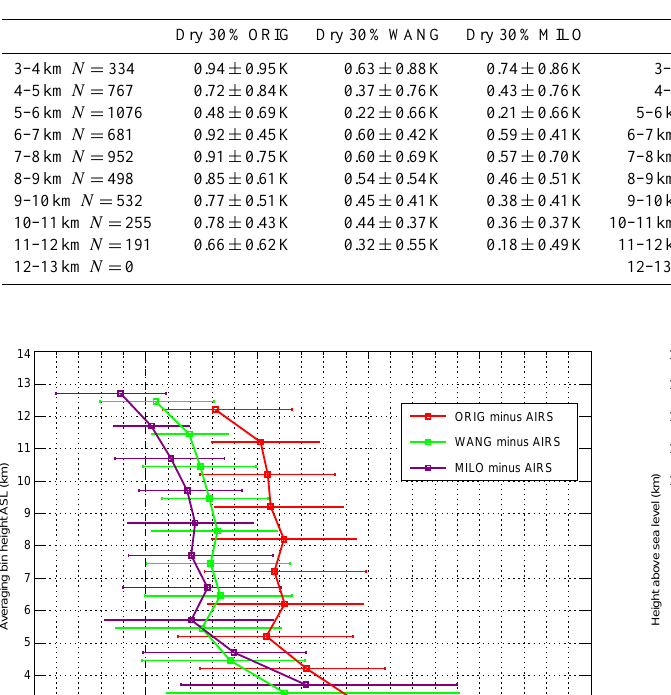
Table 4. A summary of the brightness temperature biases between the AIRS and the LBLRTM derived data over the SGP site using un/corrected RH data as input as a function of height, where the height for each spectral residual was determined as the height where the weighting function for that profile peaks. The driest 30% and moistest 30% of the data correspond to upper-tropospheric IWV thresholds of less than 0.37mm and greater than 0.96mm, respectively.